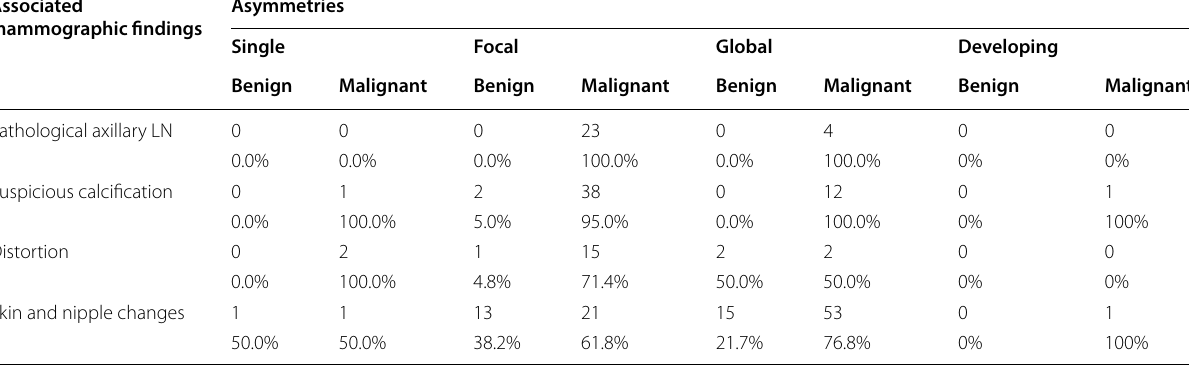
Table 2 Mammography associated findings and their correlation to the final diagnosis Associated mammographic